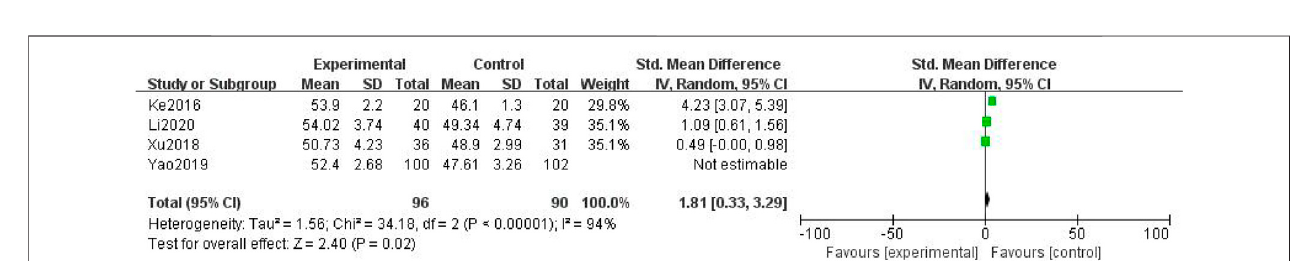
FIGURE 7 | Median nerve conduction velocity.